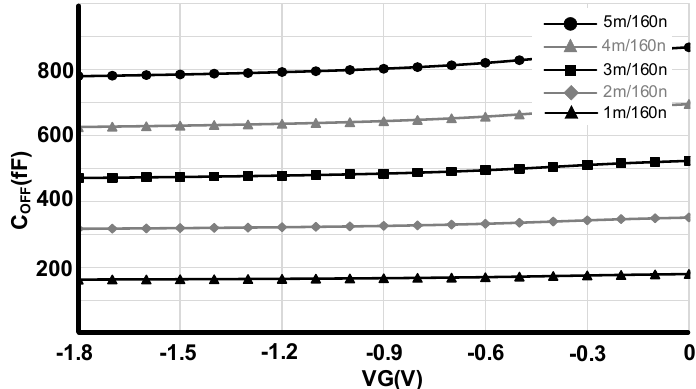
Figure 5. C OFF with respect to transistor size and gate voltages.